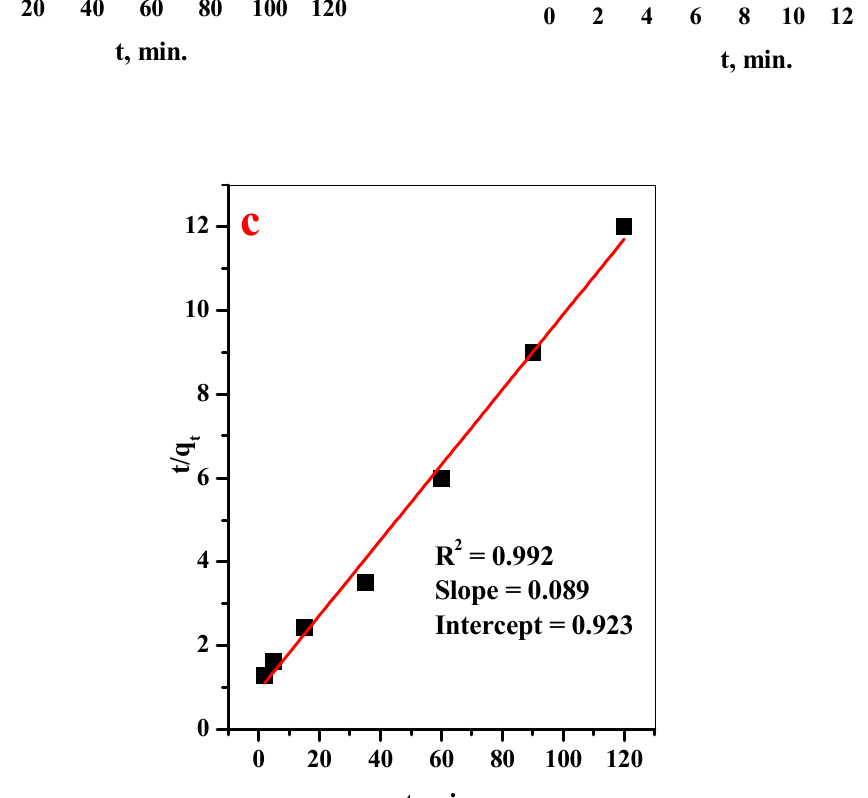
Figure 6. Effect of ( a ) contact time on removal percentage, ( b ) Pseudo-first-order, ( c ) Pseudo-second- order plots of the MB-dye over GO@CS composite beads. ([MB] = 10 ppm, [GO@CS] = 50 mg/50 mL, pH = 7, T = 25 °C). Table 1. Calculated parameters of the pseudo-first-order and pseudo-second-order kinetic models for adsorption of MB-dye over GO@CS composite beads.